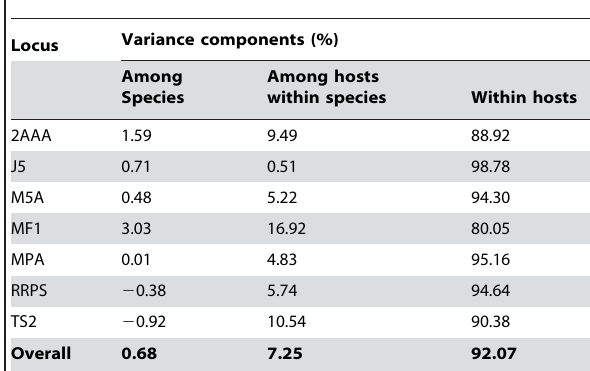
Table 4. Genetic variance components for